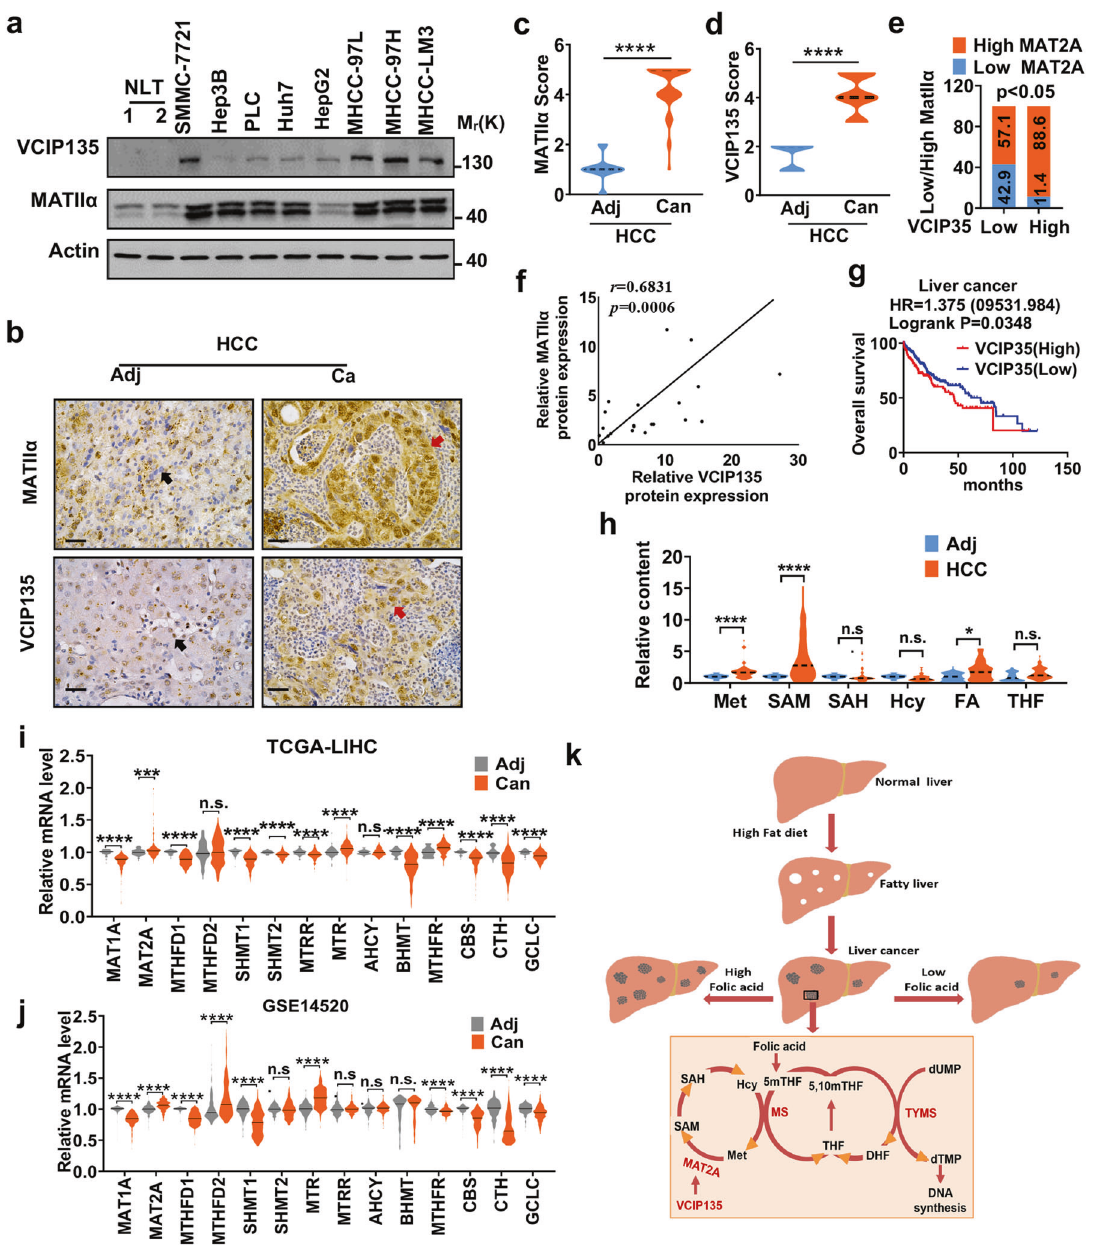
Fig. 6 MATII α and VCIP135 are upregulated in HCC and signi fi cantly associated with poor prognosis. a VCIP135 and MATII α protein levels were detected by immunoblotting from HCC cell lines. b Represent images of IHC staining with antibodies against MATII α or VCIP135 from human HCC patients ( n = 58). c , d Quanti fi cation of MATII α ( c ) and VCIP135 ( d ) protein levels according to IHC scores in HCC ( n = 58). Adj, adjacent; Can, Cancer. Median indicated as dotted lines, two-tailed t-test. e Positive correlation of VCIP135 with MATII α protein levels determined by IHC staining. The 58 samples were classi fi ed into two groups (High VCIP135, 51; Low VCIP135, 7) based on the VCIP135 level. f Positive correlation of VCIP135 with MATII α protein levels in human hepatocellular cancer tissues samples. VCIP135 and MAT2A protein expression were detected by immunoblotting ( n = 21). Spearman correlation, two-tailed. g Kaplan – Meier survival curves for patients with high VCIP135 expression have poorer overall survival compared with patients with low VCIP135 expression in liver cancer. Cutoff value used in analysis is 706. Log-rank (Mantel-Cox) test. FA, folic acid. h Levels of one-carbon metabolites from paired HCCs and non-tumor liver tissues of patients, ( n = 44 per group). Median indicated as dotted lines, two-tailed t-test. i , j Different one-carbon metabolism-related genes expression levels in patients (TCGA, i and GSE14520, j ). Median indicated as dotted lines, two-tailed t-test. k Working model. Higher folate diet enhances while folate free diet attenuates HCC development. Data in a is representative of three independent experiments. n.s. donates for no signi fi cance, * P < 0.05, ** P < 0.01, *** P < 0.001 and **** P <